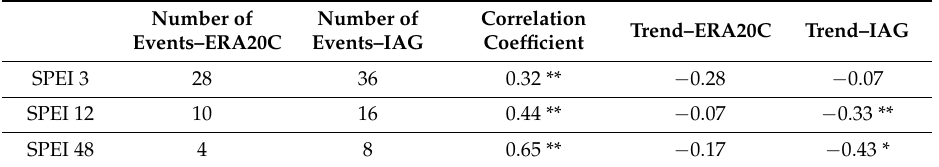
Figure 2. SPEI for 3-( a , d ), 12-( b , e ) and 48-month ( c , f ) timescales for the city of Sao Paulo in the period 1933–2010. ( a – c ) IAG weather station; ( d – f ) ERA20C reanalysis; ( g – i ) CRU. Red (blue) regions in the graph represent negative (positive) SPEI values. The solid line marks the threshold SPEI = − 1.5. Table 1. Number of events, Spearman correlation coefficient and trend for observation (IAG) and reanalysis (ERA20C) data in the city of Sao Paulo, from 1933 to 2010. The trend is represented by the slope of the regression line. * indicates the significant trend (according to MK test) or correlation coefficient (according to t-test) at α = 0.1 and ** indicates the significant trend/coefficient at α =